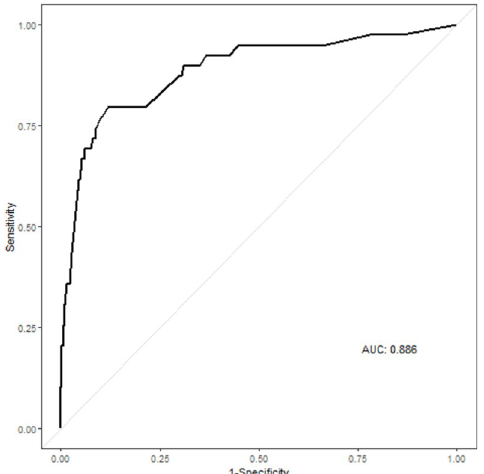
Fig 2. Receiver operating characteristic curves for the multiple logistic regression analysis model of risk factors for renal infarction. Abbreviations: AUC, area under curve.